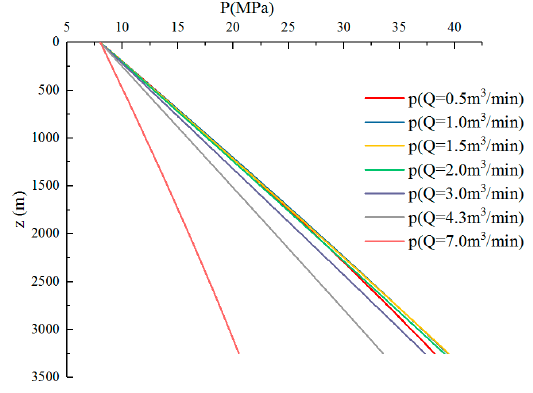
Figure 5. Pressure distribution under different displacement.